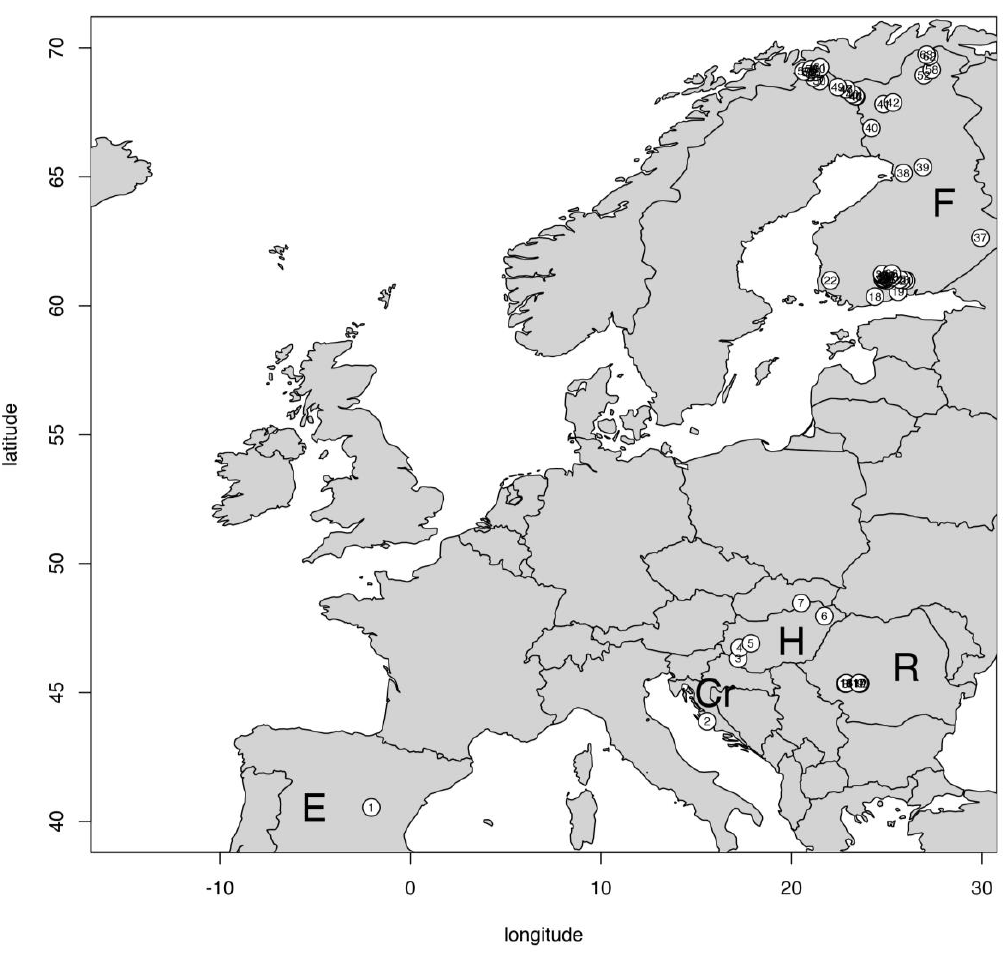
Figure 1. Location of the lakes in the study across Europe (Cr: Croatia, E: Spain, F: Finland, H: Hungary, R: Romania). Table 1. Lakes, latitude, depth, region, temperature.